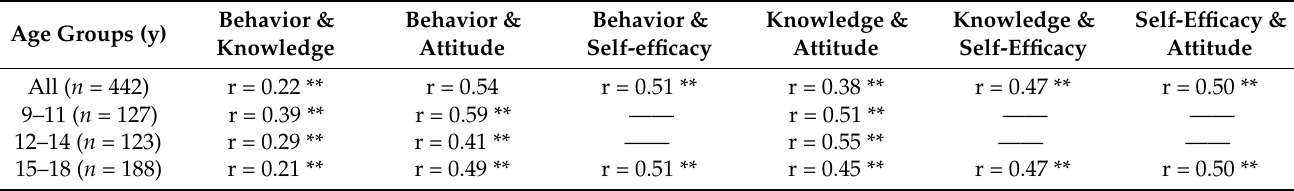
Table 4. Correlations of Participants’ Subscales by Age Group.